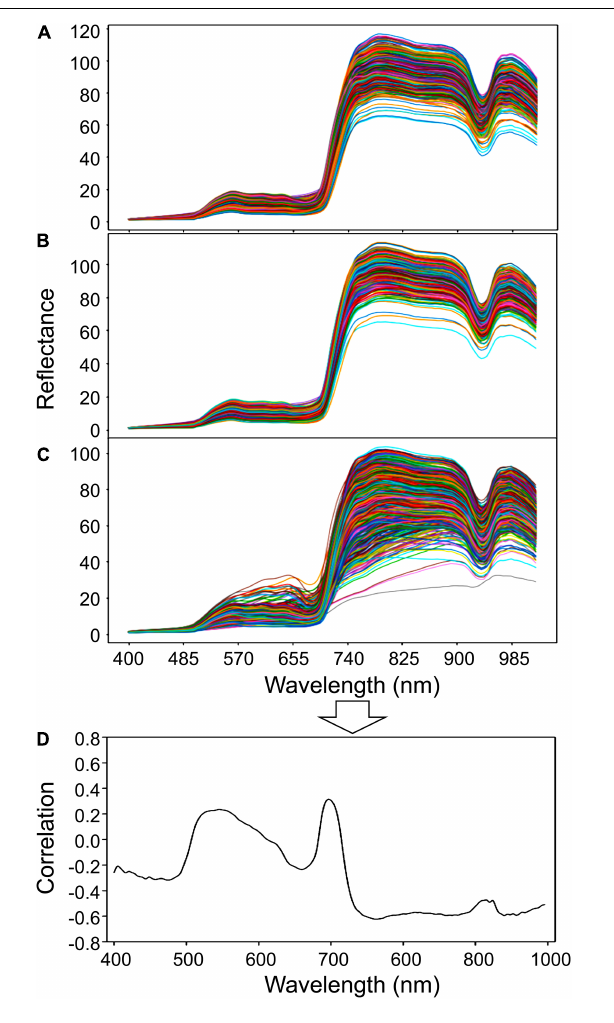
FIGURE 10 | Wavelength graphs of (A) healthy areas, (B) asymptomatic areas, (C) infected areas and (D) graph of the correlations of each wavelength found through correlation